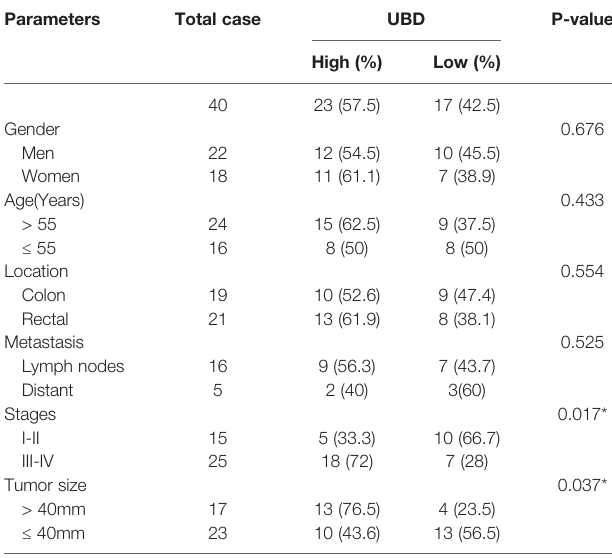
TABLE 1 | Correlation between UBD expression and clinicopathologic characteristics in CRC patients.